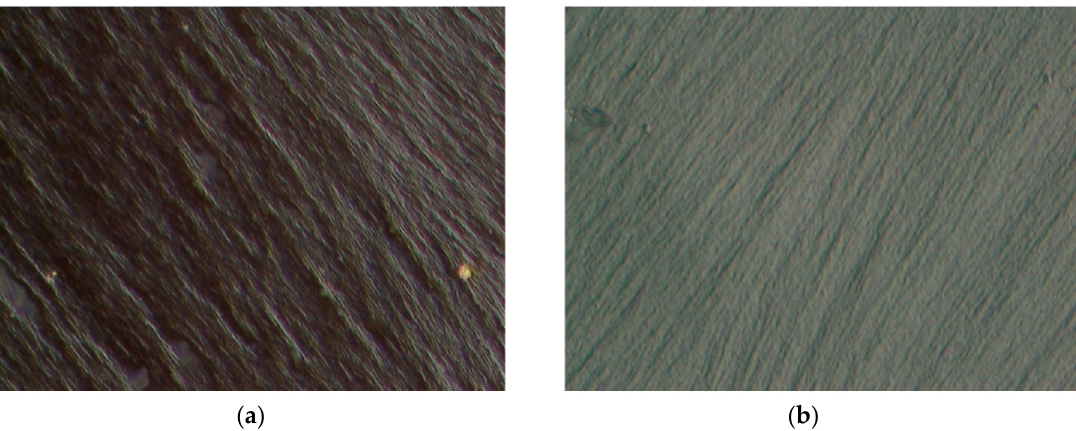
Figure 7. The fracture surfaces of neat DCPD (( a ) room temperature, ( b ) cryogenic temperature, up to 2000× magnification).